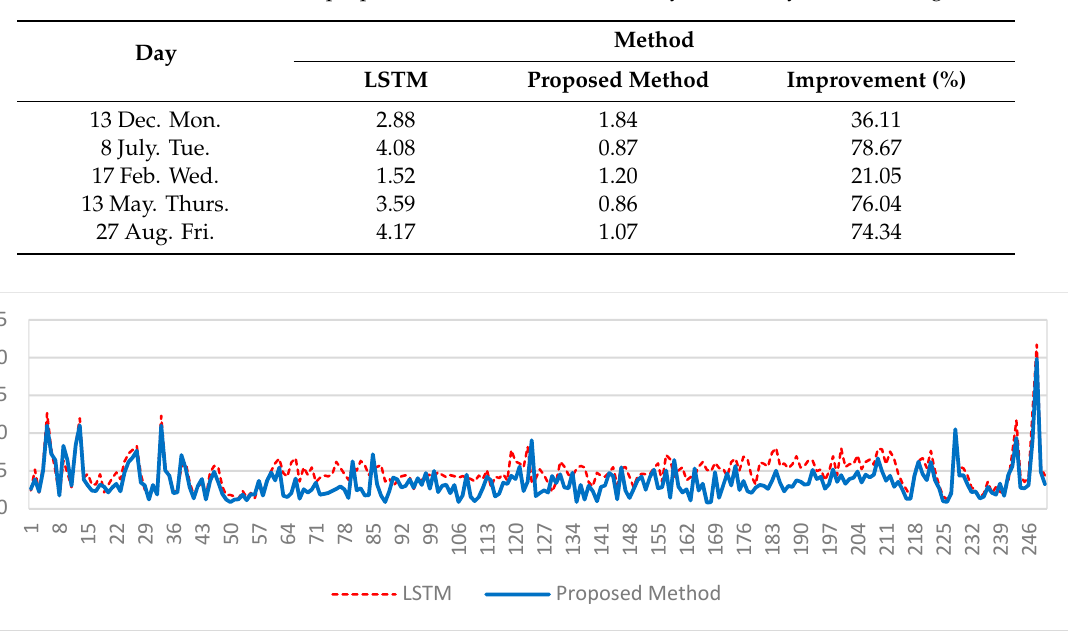
Table 2. MAPE of LSTM and proposed method for five randomly chosen days in the testing data.